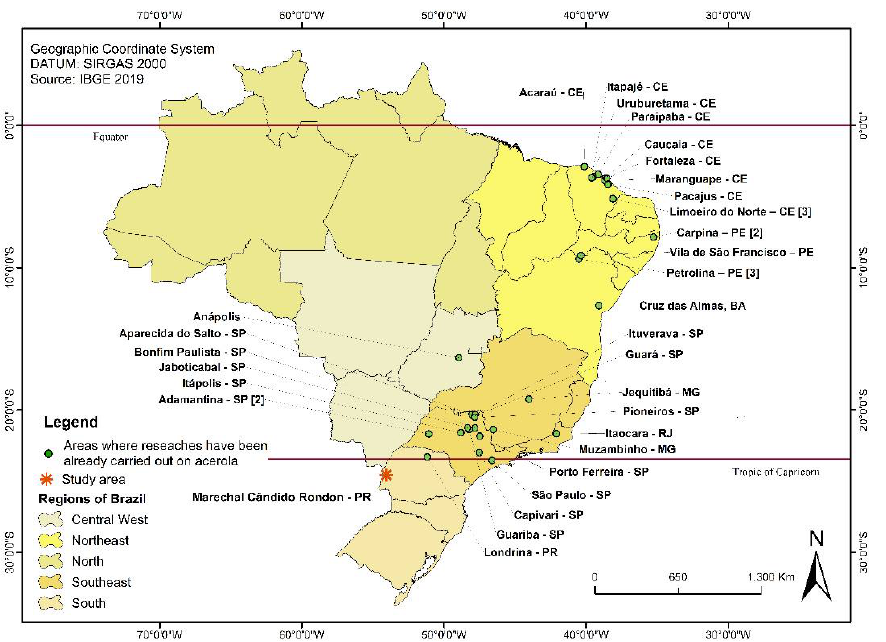
Figure 1. Map of Brazil with symbols indicating the areas where research has already been carried out on